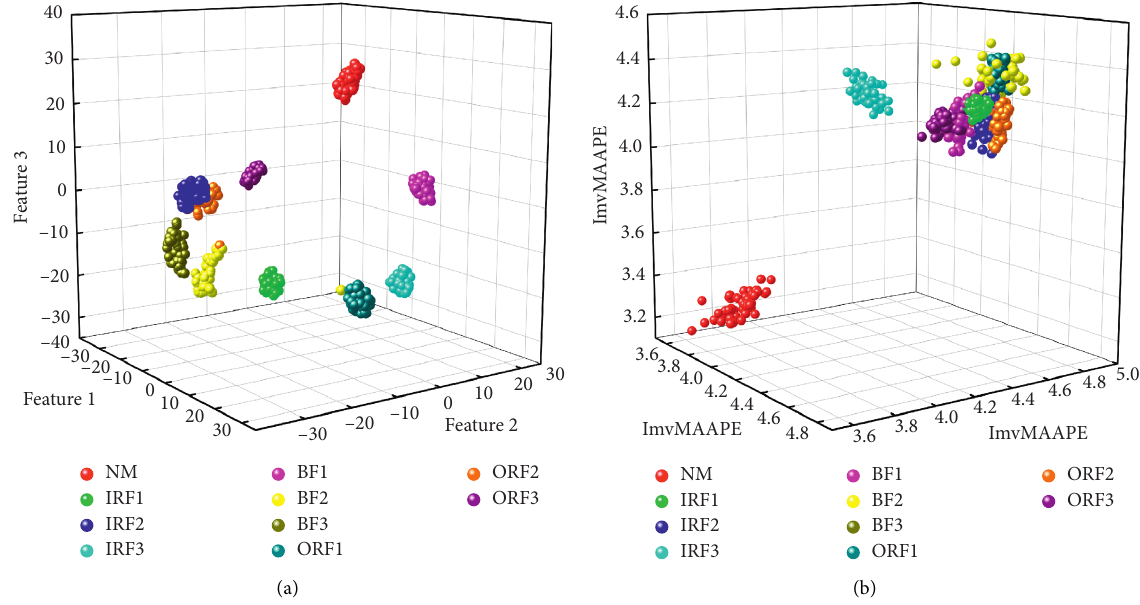
Figure 15: (a) 3D feature map processed by T-SNE; (b) 3D feature map without t-SNE processing.